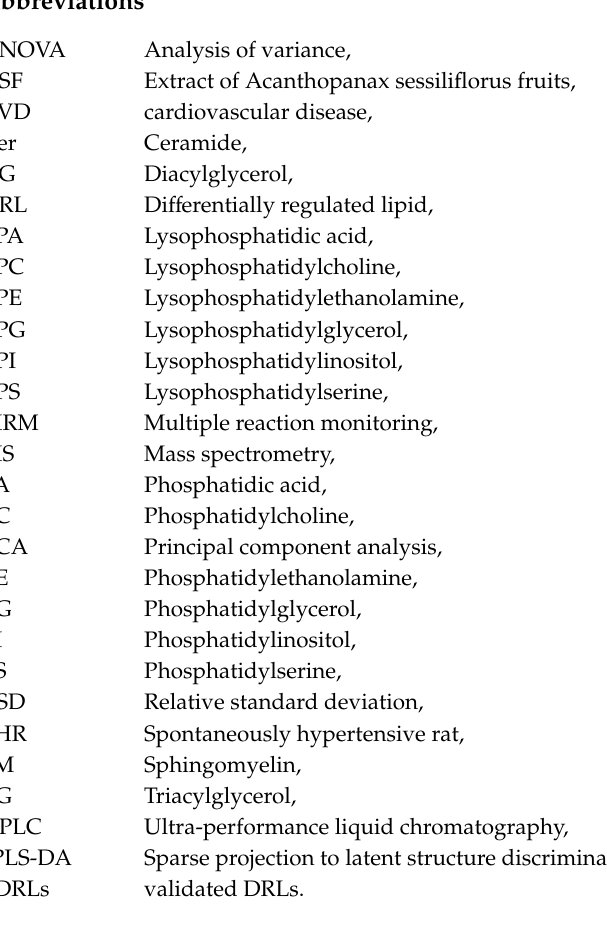
Supplementary Materials: Figure S1: PCA score plot of lipid profiles obtained from the six pooled samples of the normal control (G1), SHR (G2), SHR + Drug 100 mg / kg (G3), SHR + ASF 200 mg / kg (G4), SHR + ASF 400 mg / kg (G5), and SHR + ASF 600 mg / kg (G6). Table S1: Validation study of twelve lipid standards using UPLC–QTOF / MS and the LODs of each compound. Table S2: The list of various lipids analyzed from the six pooled samples (normal control, SHR, SHR + 100 mg / kg of Drug, SHR + ASF 200, 400, 600 mg / kg) of rat serum by UPLC–QTOF / MS. Table S3: The list of di ff erentially regulated lipids (DRLs) of six pooled samples (normal control, SHR, SHR + 100 mg / kg of Drug, SHR + ASF 200, 400, 600 mg / kg) selected by ANOVA test ( p value <